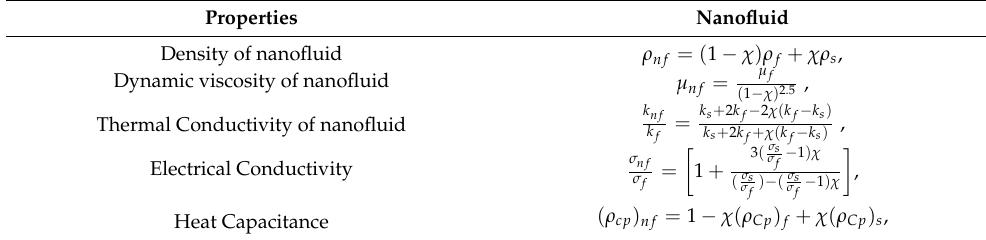
Table 2. Thermophysical properties of nanofluids are represented by mathematical relationships